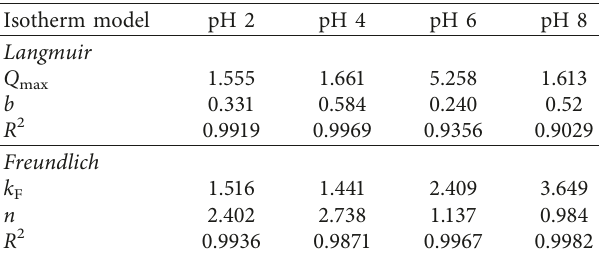
Figure 10: Freundlich plots for Cr(VI) biosorption by Grewia spp. biopolymer. Contact time 60min; T Table 2: Langmuir and Freundlich isotherms parameters for Cr(VI) biosorption on Grewia spp. biopolymer. Isotherm model